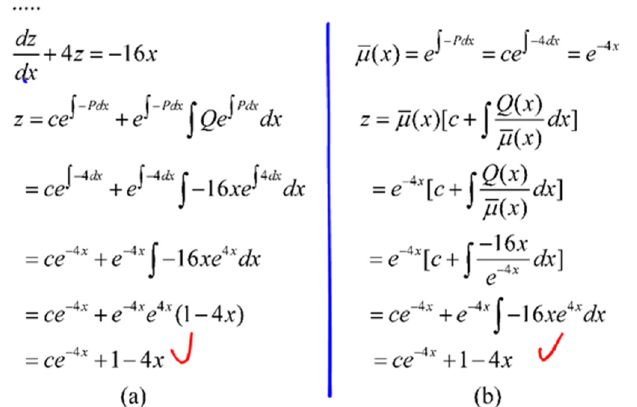
Figure 4. Reproduced examples of correct solution to the assigned ODE: ( a ) using Formula (20) and ( b ) using Formula (27).